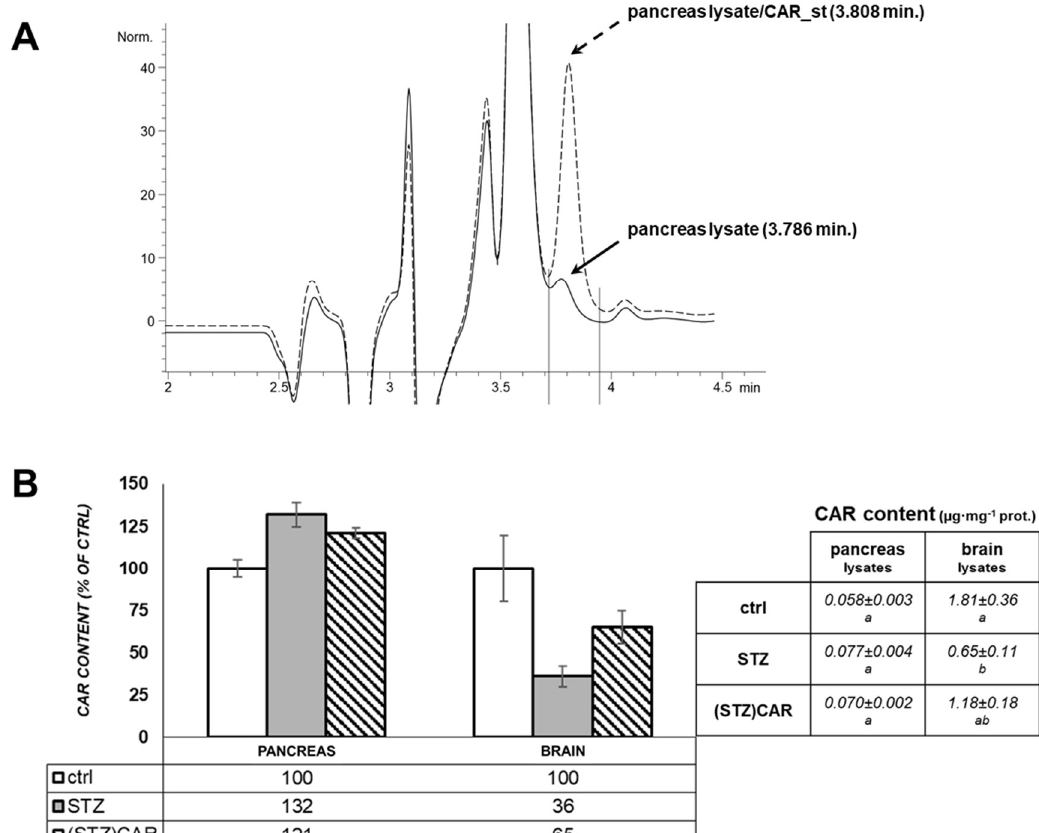
Figure 4. CAR detection in the pancreas and brains of mice that underwent STZ treatments. Analysis of CAR content by HPLC on deproteinized extracts of pancreas and brain lysates from control (ctrl), STZ and (STZ)CAR mice. ( A ) Representative chromatograms for the lysates from control pancreas (upper figure) and for the pancreas lysate 1:1 mixed with a CAR standard solution (1 µ g/mL) in ultrapure water. Peaks and elution times are pointed by the red arrows. ( B ) Normalized concentrations of CAR per mg of total protein in the starting pancreatic extracts are expressed in the histograms as percent values with respect to the control (100%). Values are the mean of n = 3 ( ± S.E.M.) biological replicates. Different letters (a, b) indicate statistically different values ( t -student test; p < 0.05).